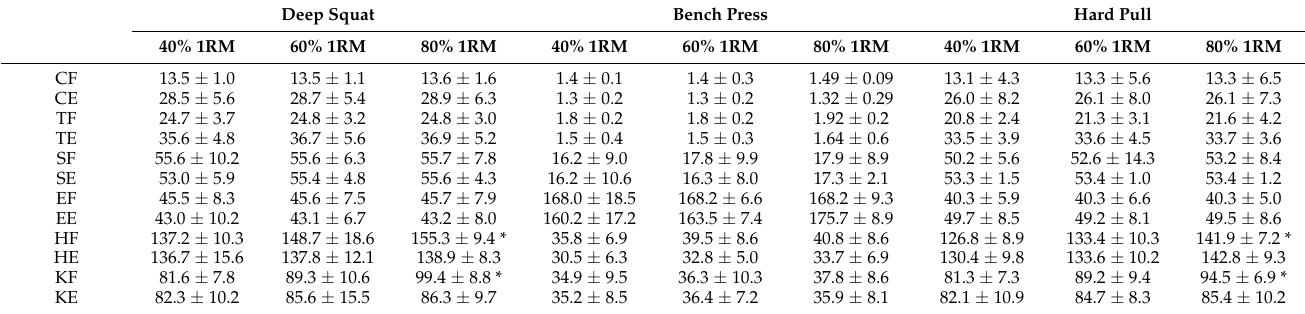
Table 1. Comparisons of the peak values of the different load intensity test angles ( ◦ ).